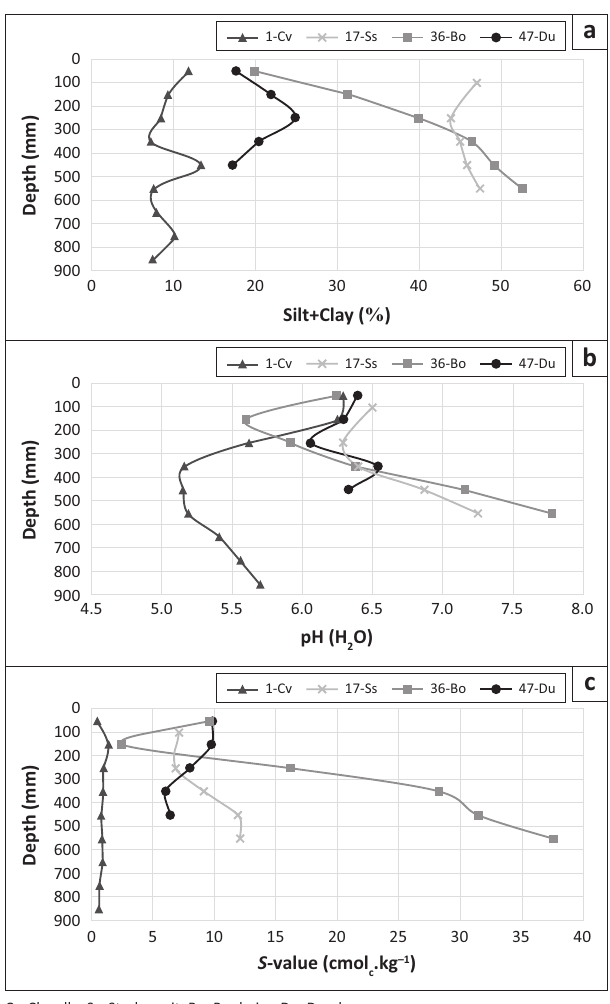
FIGURE 4: Vertical distribution of selected properties in modal profiles. (a) Silt+clay contents, (b) pH profiles and (c) S